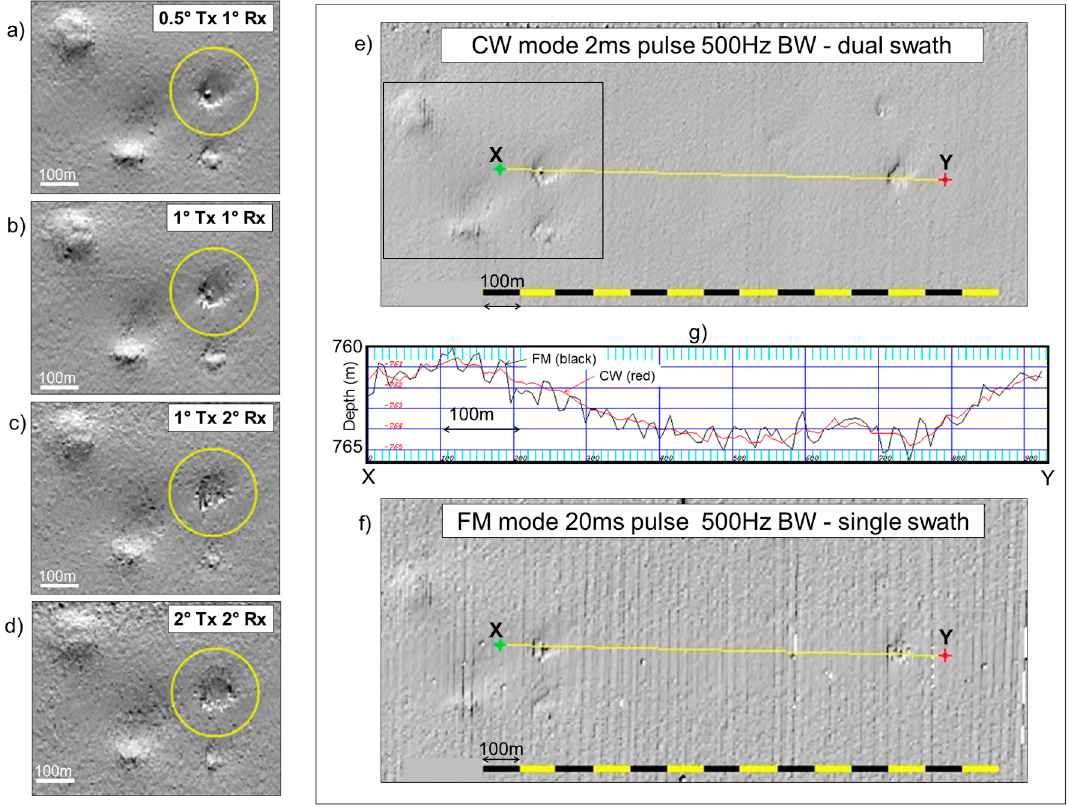
Figure 2. (left), Effect of changing beam width on the resolution of a specific small target at near normal incidence. EM710 system, 760m depth. ( a ) 0.5° Tx × 1.0° Rx; ( b ) 1.0° Tx × 1.0° Rx; ( c ) 1.0° Tx × 2.0° Rx; ( d ) 2.0° Tx × 2.0° Rx. (right) illustrating the impact of switching from CW to FM pulse over